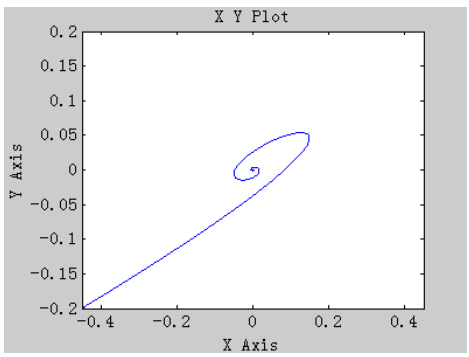
Figure 13. Rotor trajectory.